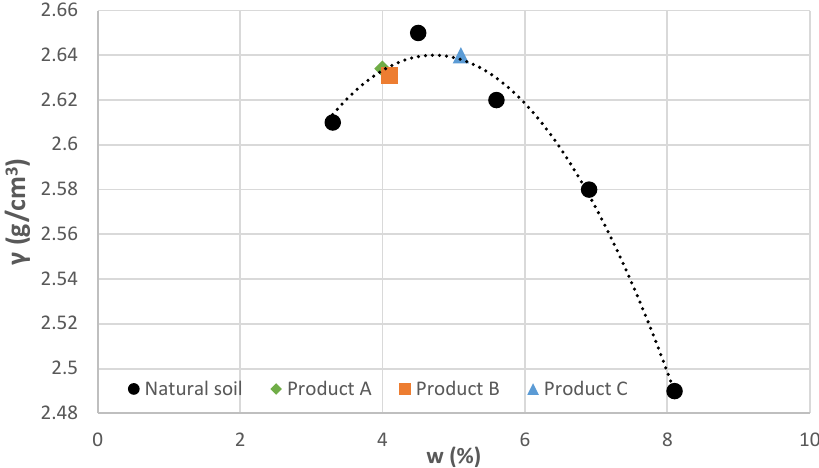
Figure 4. Results of the modified Proctor test for products A, B, and C at 7 days after the conditioning.